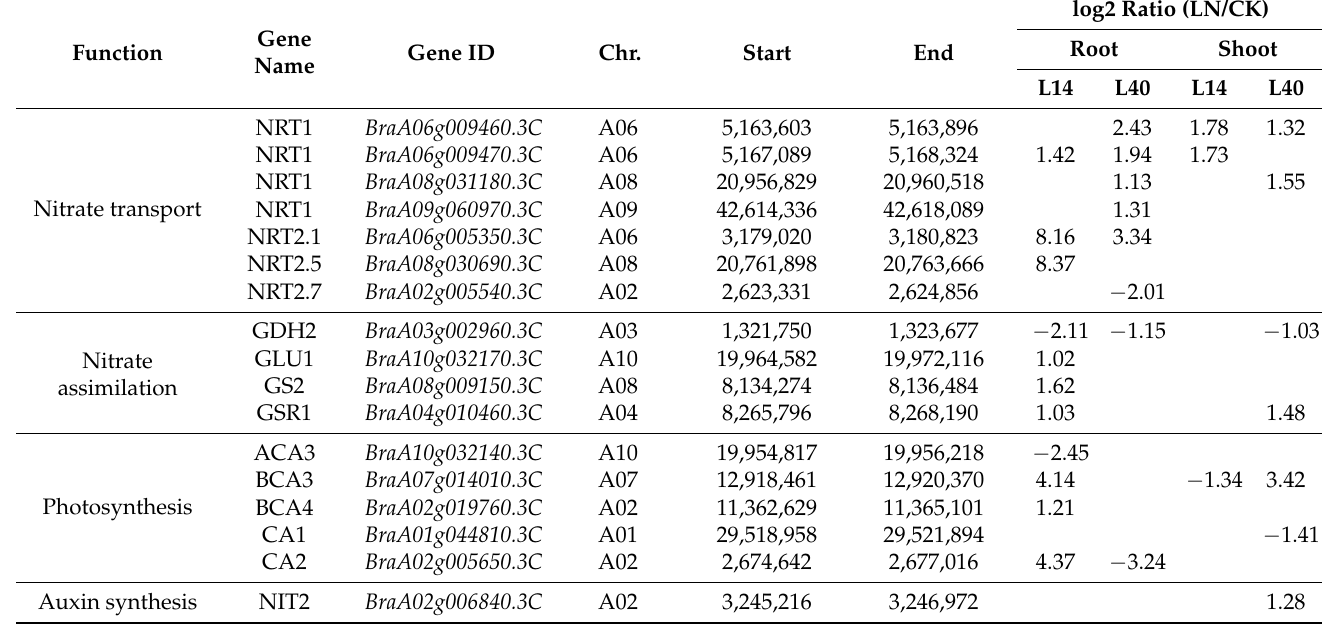
Table 4. Number of identified DEGs related to LN stress